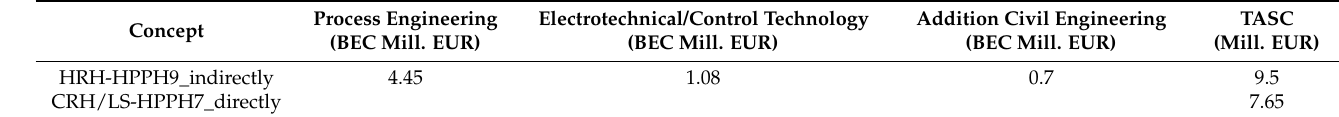
Table 3. Integration